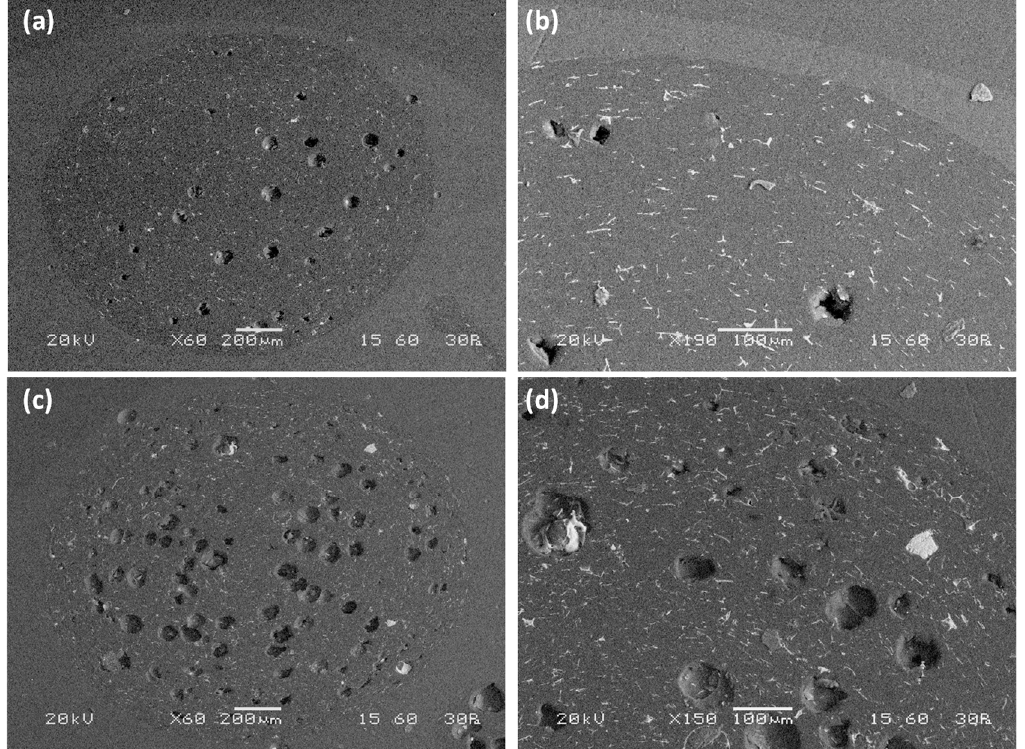
Figure 8. Morphology of two composite filament cross-sections produced using F3 filler: granulometry − 90 μ m and infill ratio of 10 vol.% on ×60 ( a ) and ×190 ( b ); granulometry of − 90 μ m and infill ratio of 20 vol.% on ×60 ( c ) and ×150 ( d ).